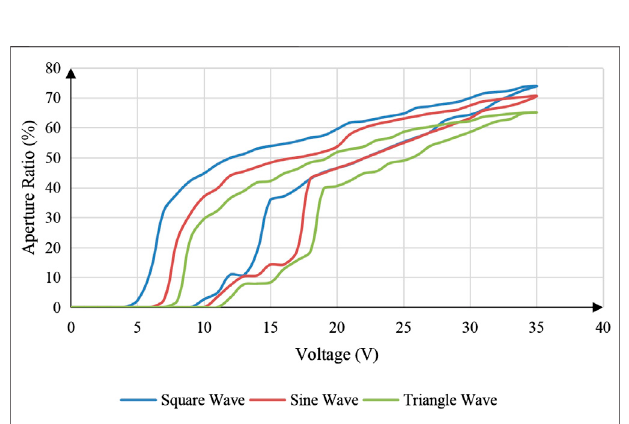
FIGURE 8 | The hysteresis curves of EWDs driven by a square wave, a sine wave and a triangle wave.